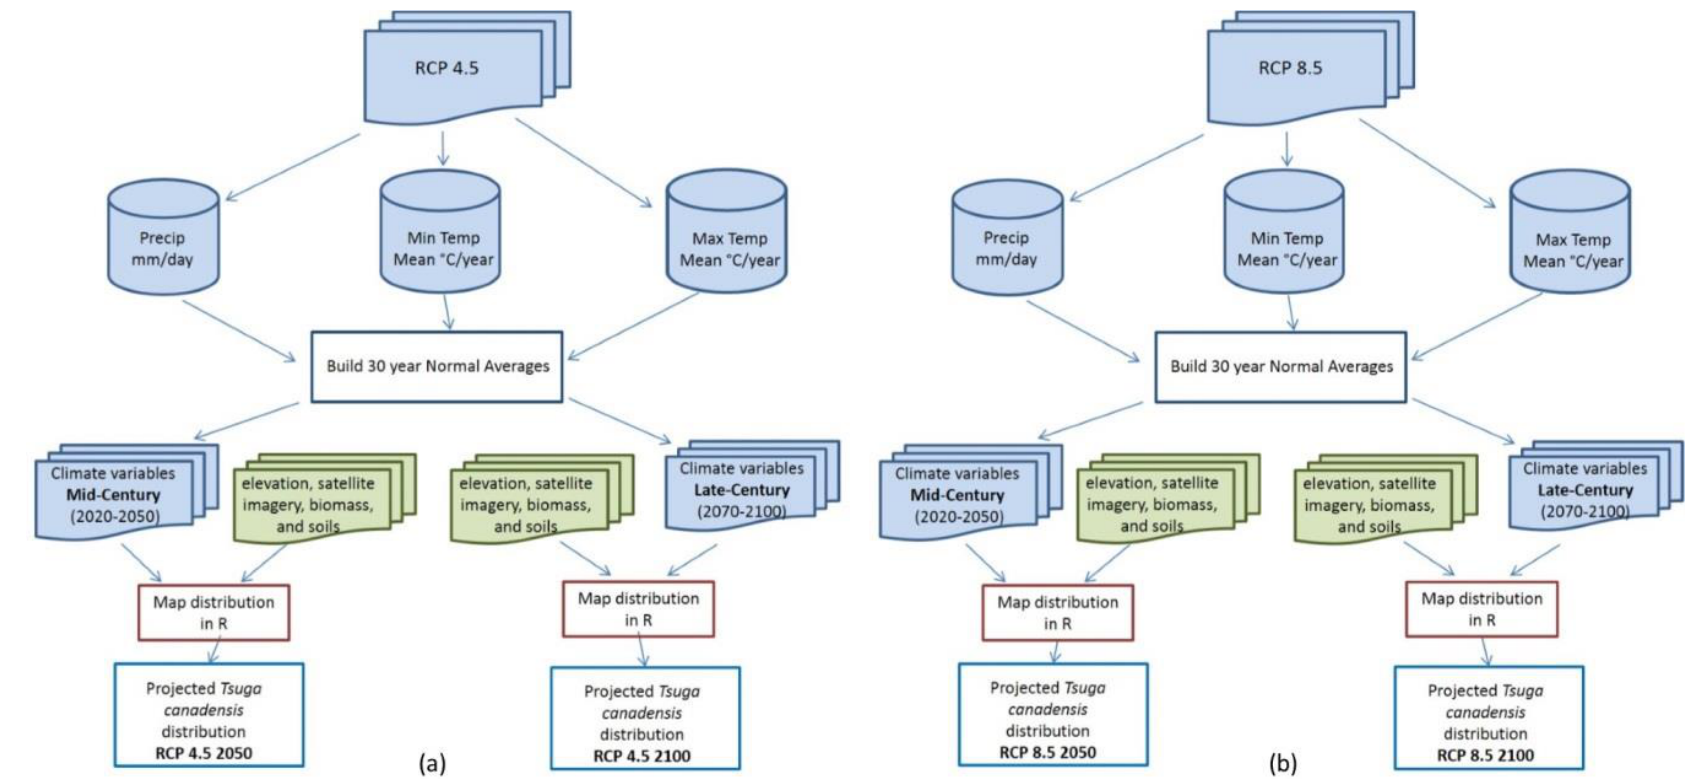
Figure 2. The general work flow used to process raw netCDF files (available from NASA) into 30 years normal averages that more precisely mirror the PRISM climate data used in Tsuga canadensis current distribution model along with the other predictor variables (green) that remained constant, resulting in four map outputs. ( a ) Representative Concentration Pathways (RCP) 4.5 2050, RCP 4.5 2100 and ( b ) RCP 8.5 2050, RCP 8.5 2100.